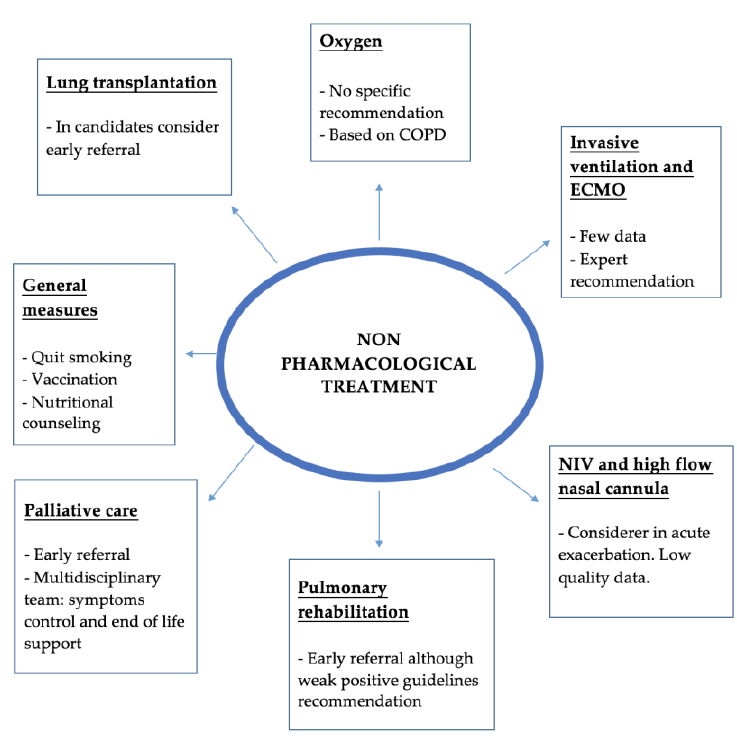
Figure 2. Summary of the main non-pharmacological treatment. ECMO — Extracorporeal membrane oxygenation; NIV — Non-invasive ventilation.